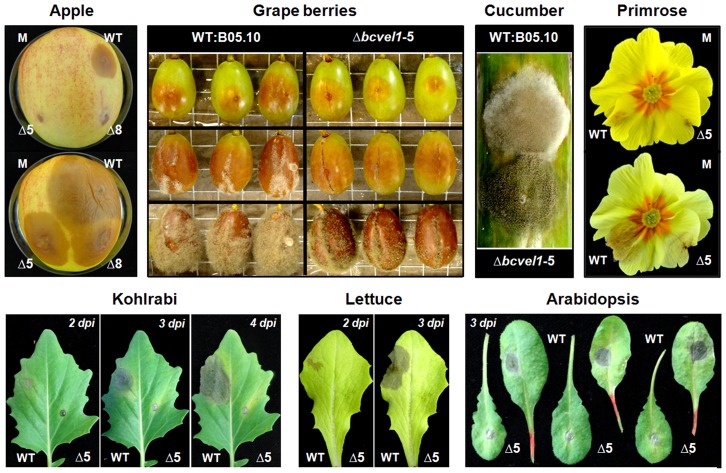
Disease symptoms on other plant tissues.All plant tissues were inoculated with conidial suspensions of strains WT:B05.10 and Δbcvel1 (two independent mutants, Δ5 and Δ8). Surfaces of apple, cucumber and grape berries were wounded with a needle prior to inoculation. Pictures of infected apple fruit were taken 5 and 8 dpi, of infected grape berries 3, 6 and 9 dpi, cucumber 7 dpi, and of the infected primrose flower 2 and 4 dpi. Leaves of young kohlrabi and lettuce plants were detached prior to inoculation while leaves of Arabidopsis thaliana Col-0 plants were separated 3 dpi. M, mock-treated.